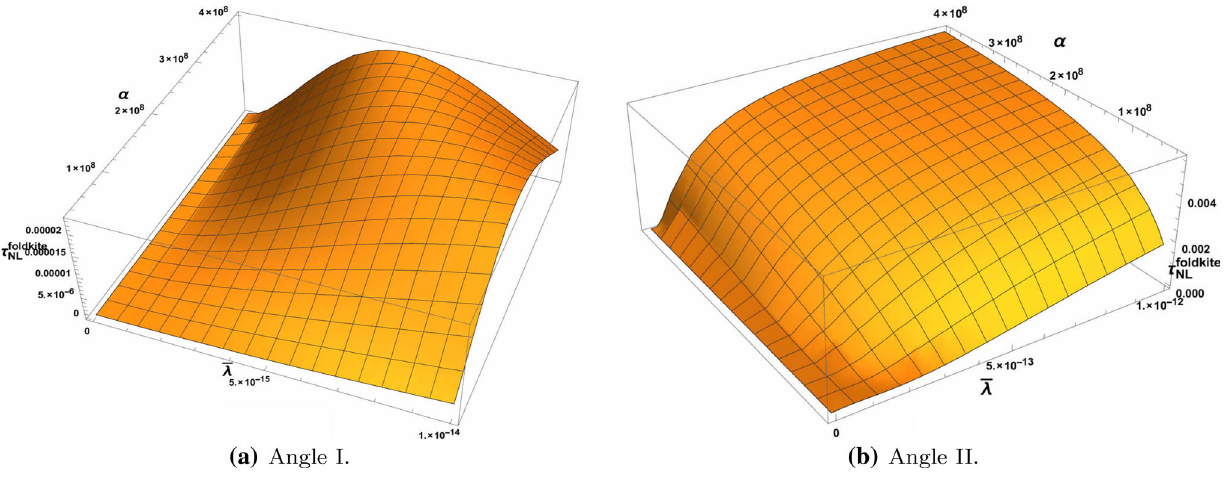
Fig. 27 Representative 3D diagram for equilateral non-Gaussian three point amplitude vs. the model parameters α and ¯ λ for N cmb = 60 in two different angular